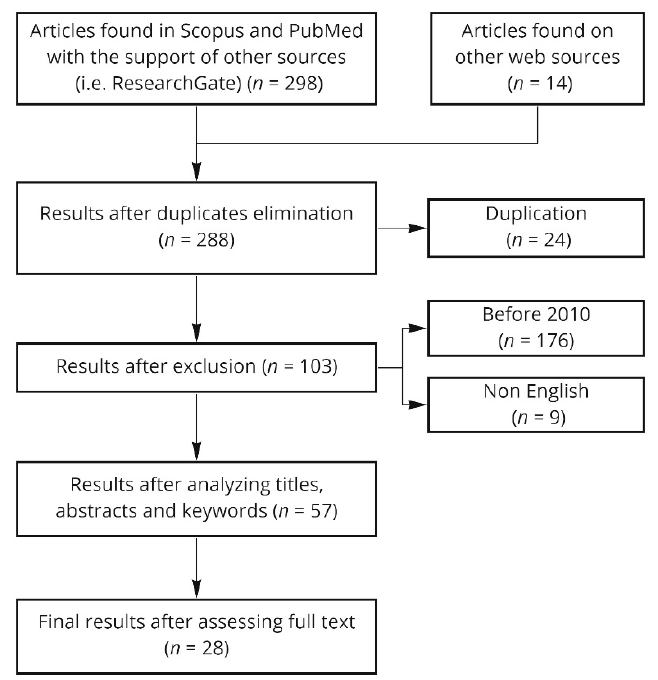
Figure 2. Flow diagram of literature search. Table 1. Searching rules and selecting criteria for the literature review.